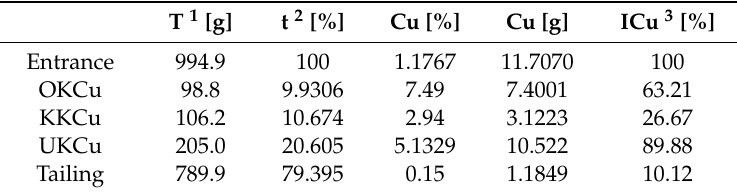
Copper flotation e ffi ciency obtained by using Na-iPrX powder (produced by a conventional process).